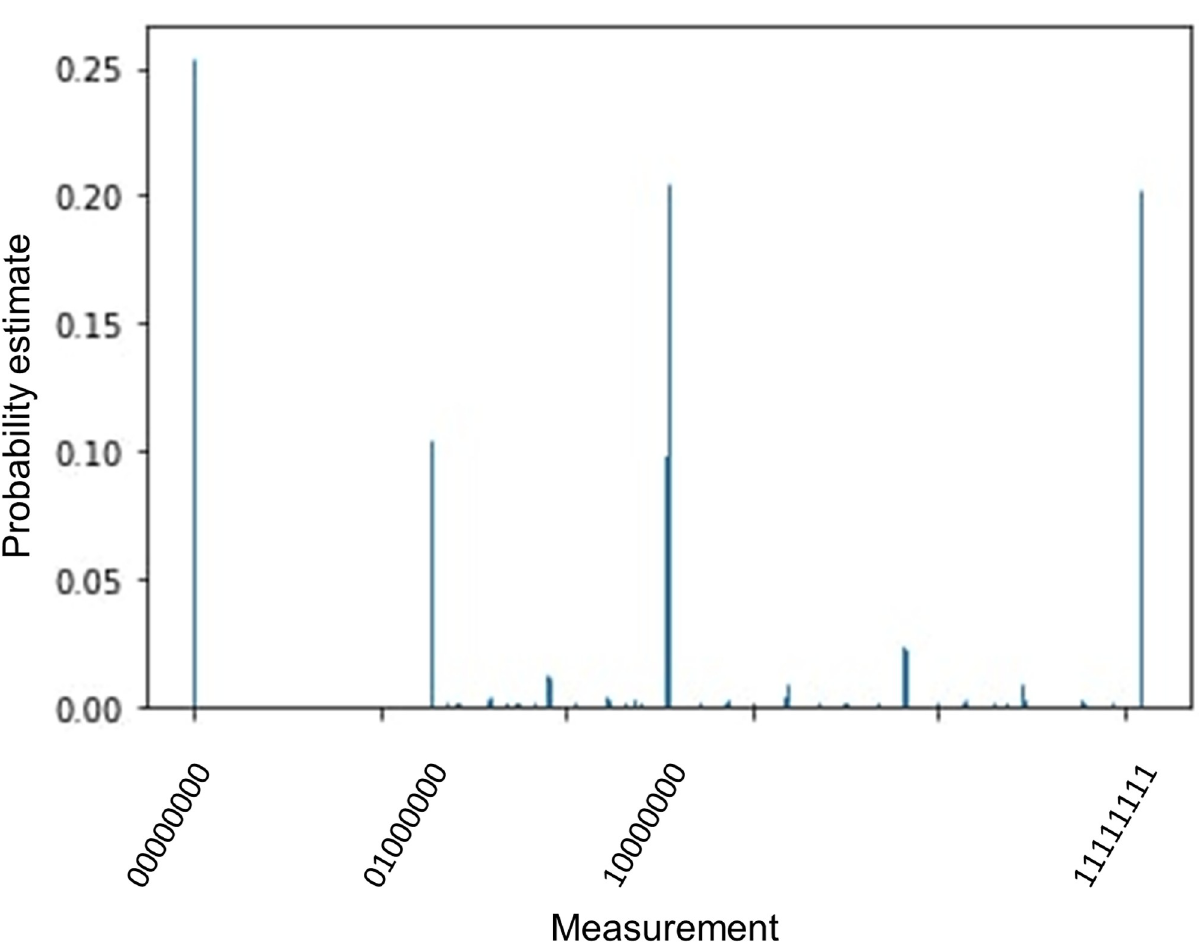
Fig 8. Probabilities of measurements for order finding